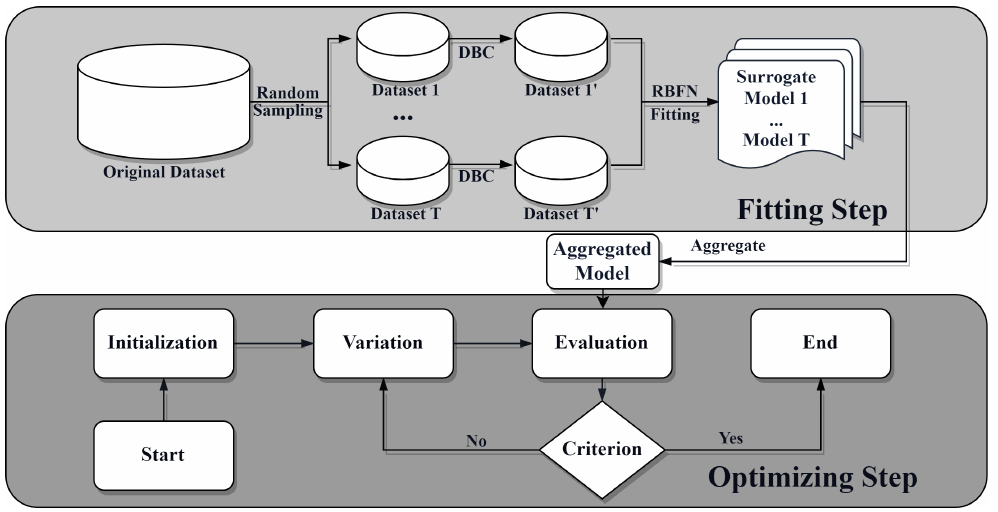
Figure 4. The diagram of complete